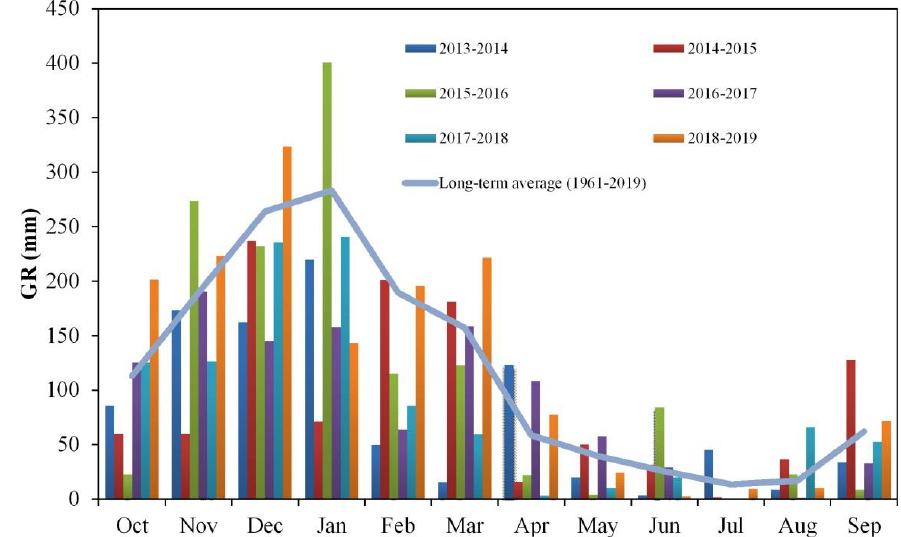
Figure 3. Monthly rainfall of each hydrological year (2013 to 2019) and the long-term average in the seasonally dry Atlantic Forest (SDAF).